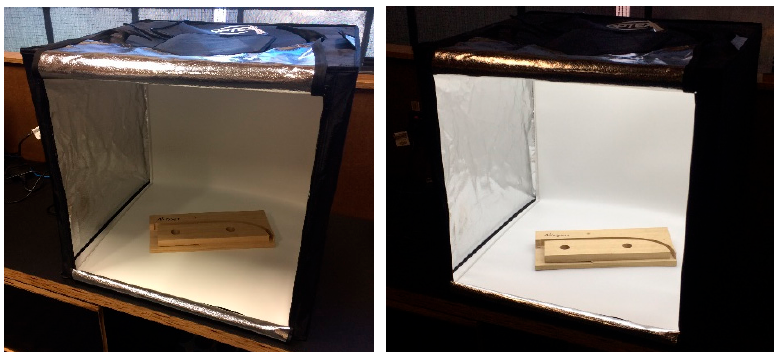
Figure 2. Photo studio lighting kit used to grade specimens.